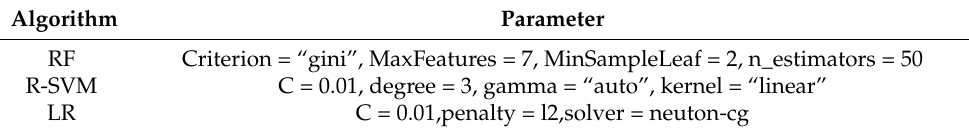
Table 3. Algorithm’s